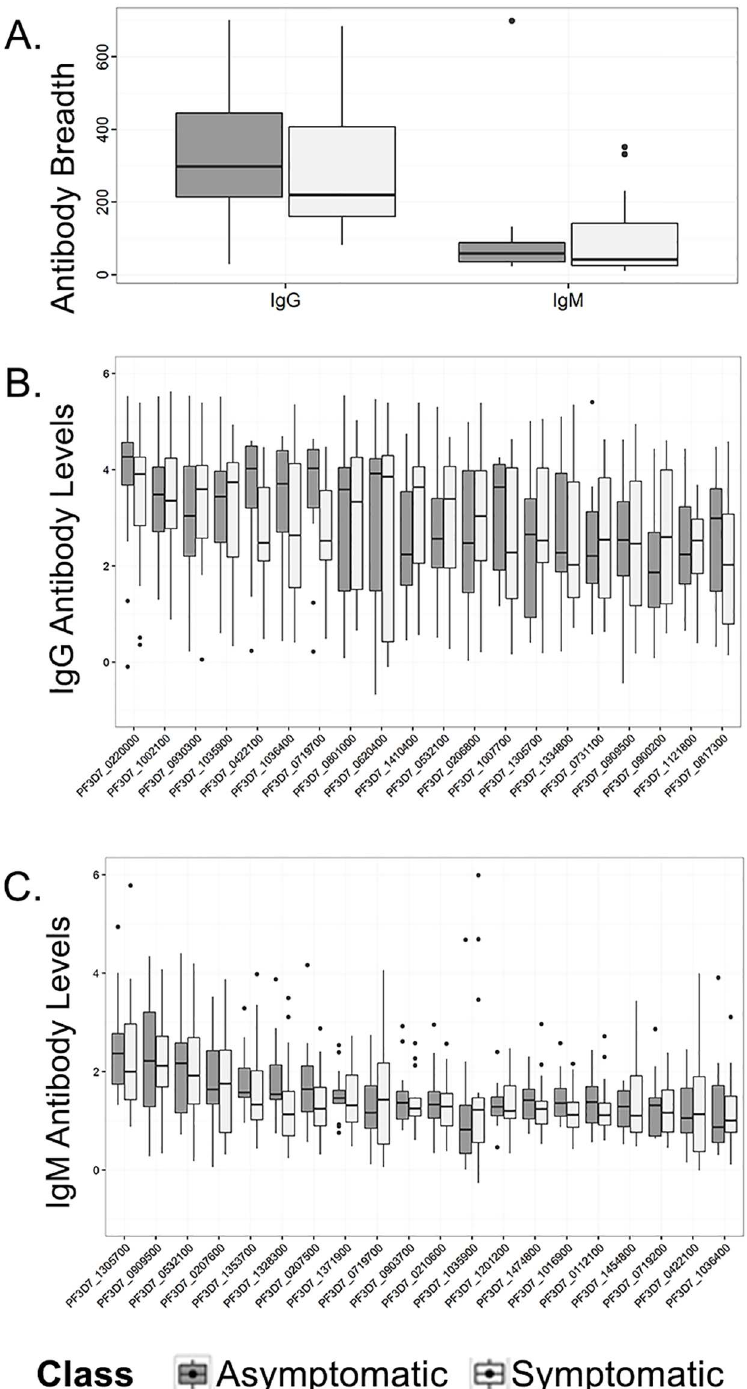
Fig 2. Results from Pf protein microarrayanalysis of IgG & IgM antibody repertoires from asymptomatic and symptomatic malaria patients in Sud-Est, Haiti. Plasma from asymptomatic (n = 16) and symptomatic (n = 13) malaria patients from the Sud-Est Departmentin Haiti were reacted with a partial Pf proteomemicroarrays. Arrays contained3,877 peptidefragments from 2,704 uniquegenes, representing approximately 50% coverage of the Pf proteome. (A) Box plots representingantibodybreadth score per patient for both IgG and IgM, describedas sum of seropositiveresponses per individual.Breadth did not show an effect on probabilityof having symptoms. (B) Box plots of IgG responsesof asymptomatic and